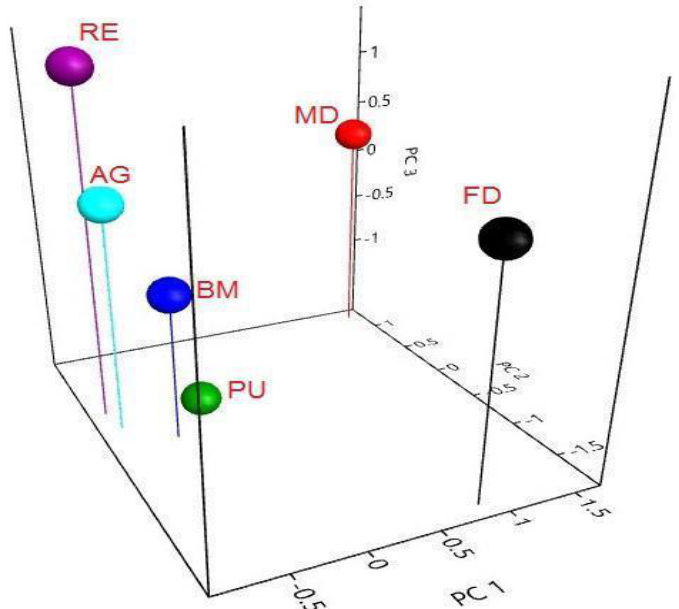
Figure 7. Principal component analysis (PCA), showing the positions of the dots relative to the components and showing how strongly independent variables are correlated with each other. The variables in the PCA were conducted for food (FD; black), medicine (MD; red), black magic (BM; blue), poultry (PU; green), agriculture (AG), and recreation (RE).